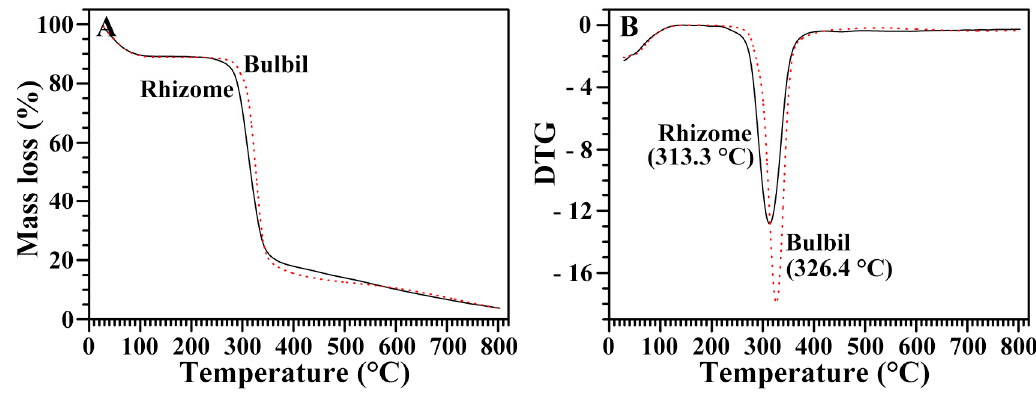
Figure 4. Thermogravimetric ( A ) and derivative thermogravimetric (DTG); ( B ) curves of starches from the rhizome and the bulbil of Chinese yam.